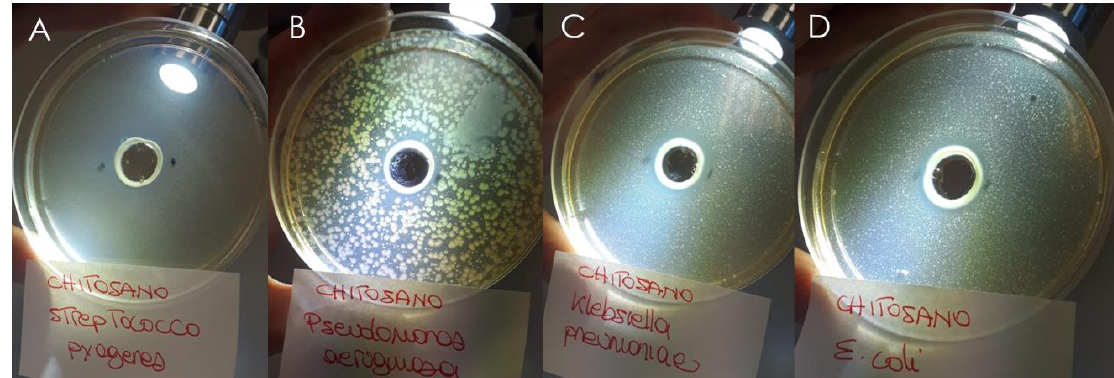
Figure 11. Inhibition halos measured for FG90 1% wt. solution for ( A ) S. pyogenes , ( B ) P. aeruginosa , ( C ) K. pneumoniae and ( D ) E. coli .